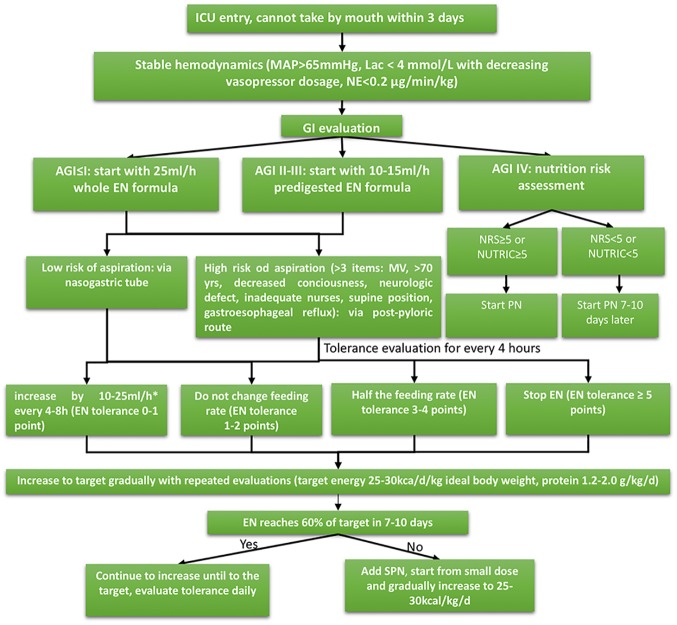
Enteral feeding algorithm.Before EN initiation, Hemodynamic should be stabilized with MAP>65 mmHg and lactate<4 mmol/l, or vasopressor dose was decreasing. GI function was then evaluated with the AGI staging system. For pateints with AGI of I, EN could be started at 25 ml/h. For patients with AGI II-III, predigested EN could be started at 10–15 ml/h. EN was withheld for those with AGI IV. If patients were at high risk of malnutrition, parenteral nutrition (PN) should started.